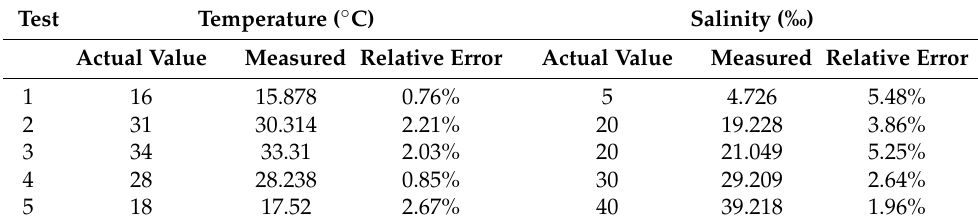
Figure 5. FPI (Fabry − Perot interferometer) optical fiber salinity sensor: ( a ) schematic diagram of sensing structure; ( b ) schematic diagram of experimental system; ( c ) reflecting spectrum to salinity ( d ) relationships between dip wavelength and temperature. Table 1. Relative error test result of FPI optical fiber salinity sensor.